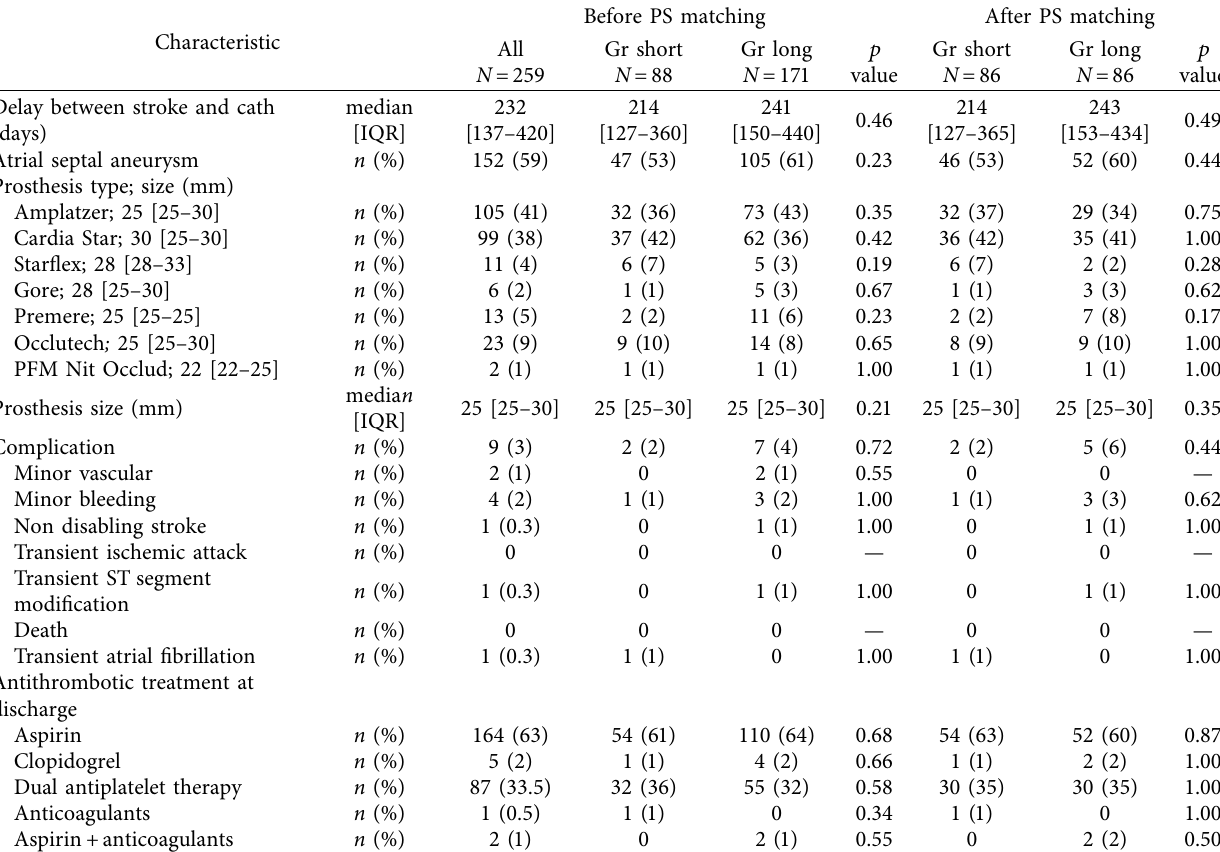
Table 2: Periprocedural